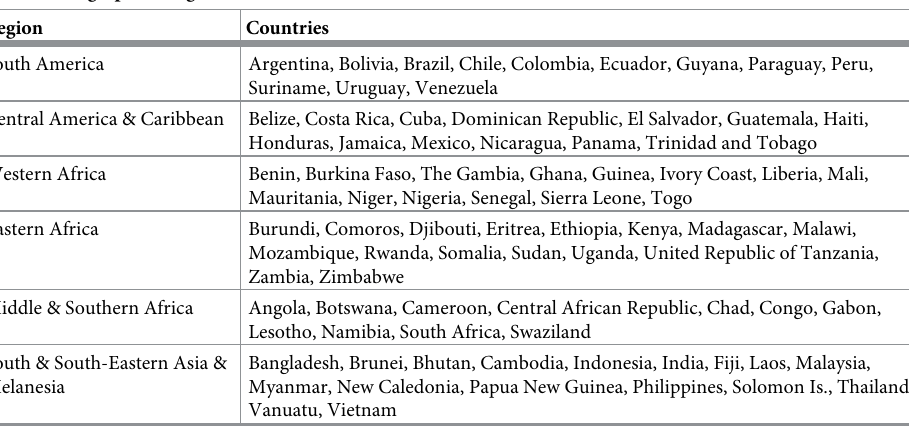
Table 2. Geographical